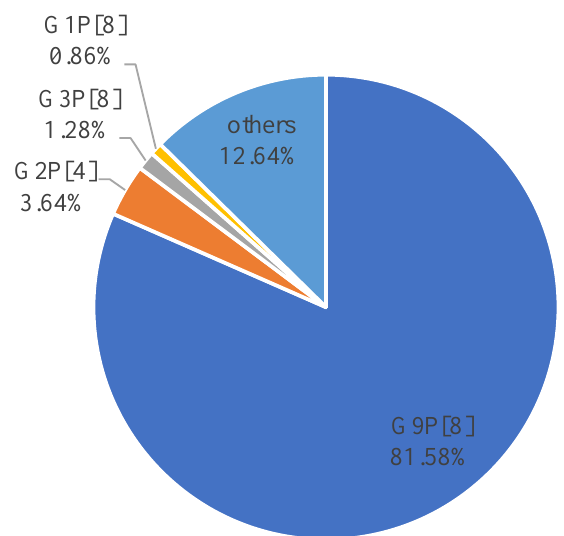
Figure 3. Composition ratio of rotavirus genoserotypes in Yantai in 2017 – 2019.